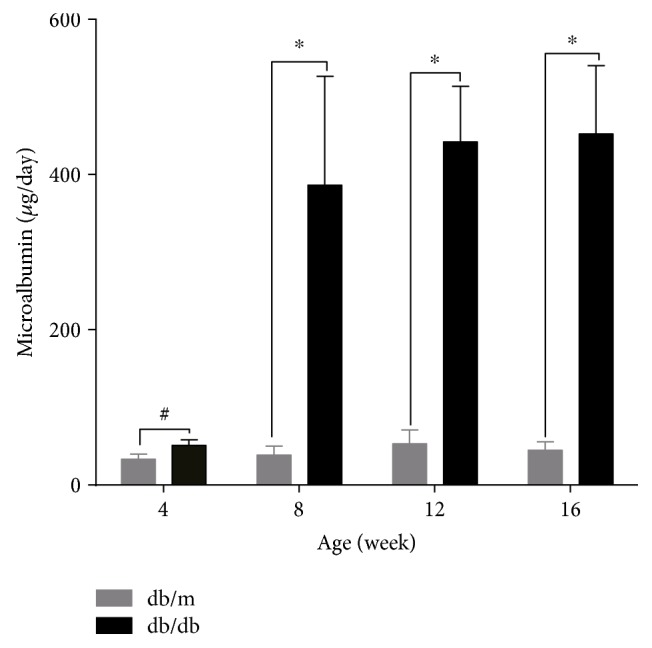
Increased albuminuria in db/db mice. db/db represents BKS.Cg-Dock7m +/+ Leprdb/JNju mice and db/m represents their lean littermates. Samples from 4-, 8-, 12-, and 16-week-old mice were examined. From 8 to 16 weeks of age, db/db mice showed increased microalbuminuria compared with their lean db/m littermates. The data are shown as the means ± SD. (white-colored bars) db/m. (black-colored bars) db/db, ∗P < 0.05 versus respective control, #P > 0.05 compared with the control.